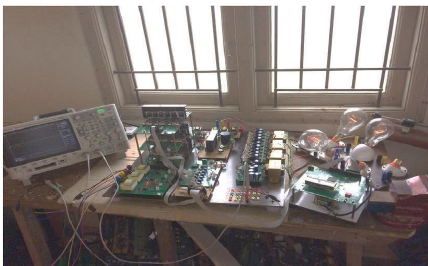
Figure 18: Loading of